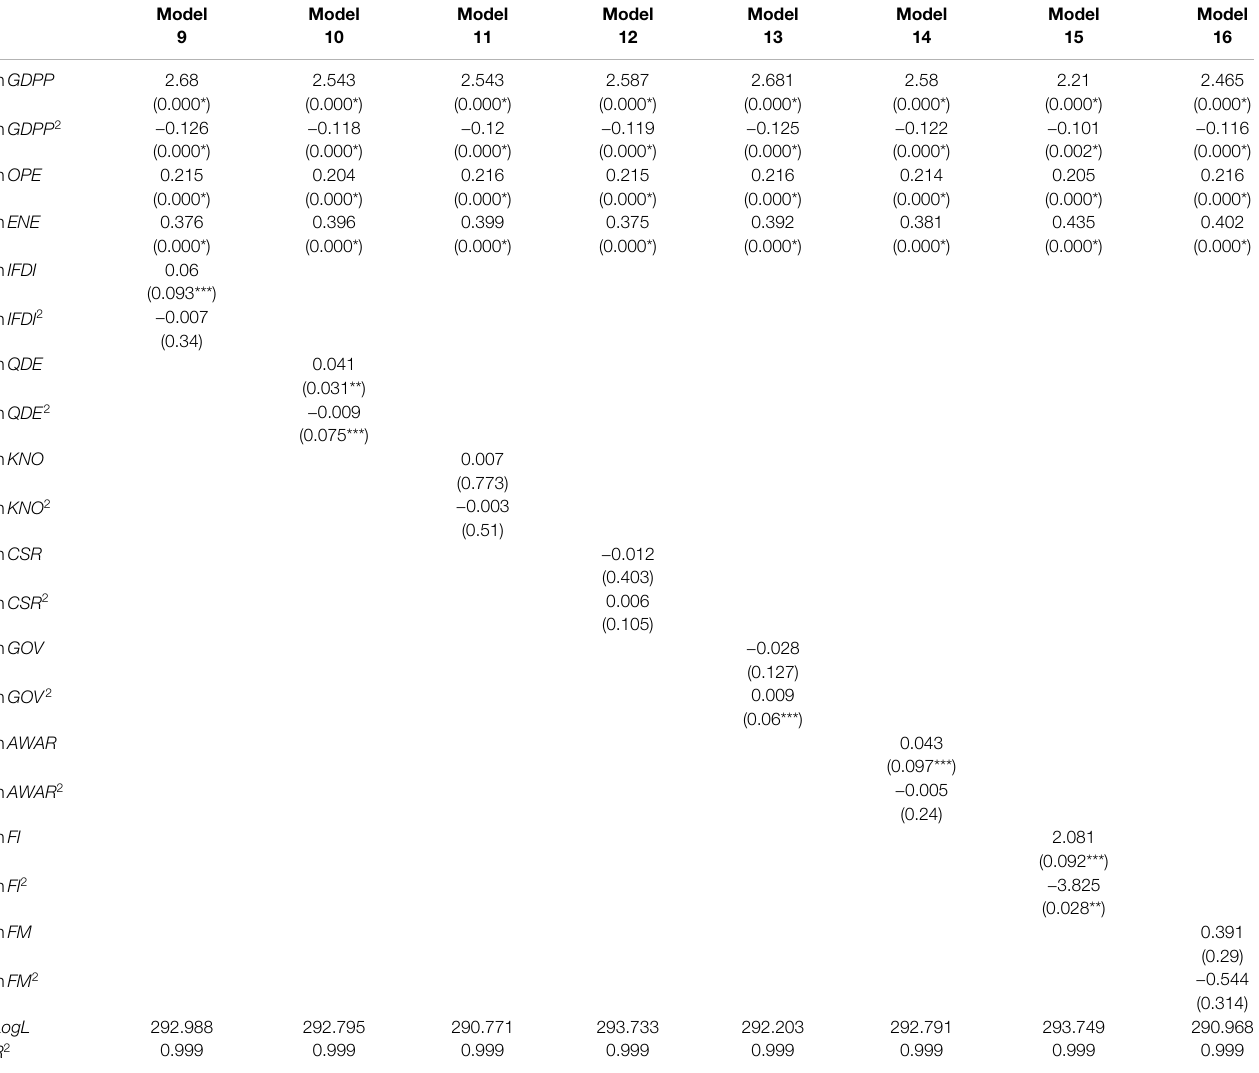
TABLE 7 | Estimation results of different models for Eq. 5